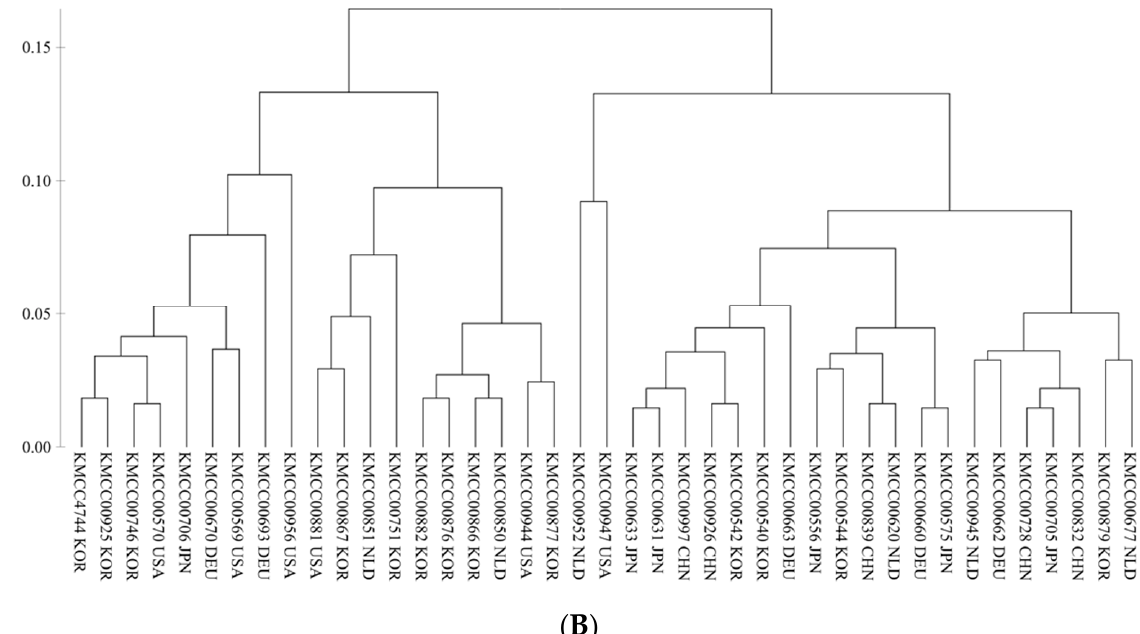
Figure 5. ( A ) The number of markers sufficient to serve as a minimum marker was determined using an accumulation curve calculated using the poppr package in R. ( B ) Phylogenetic tree illustrating discrimination of 41 Agaricus bisporus accessions using 10 selected markers.